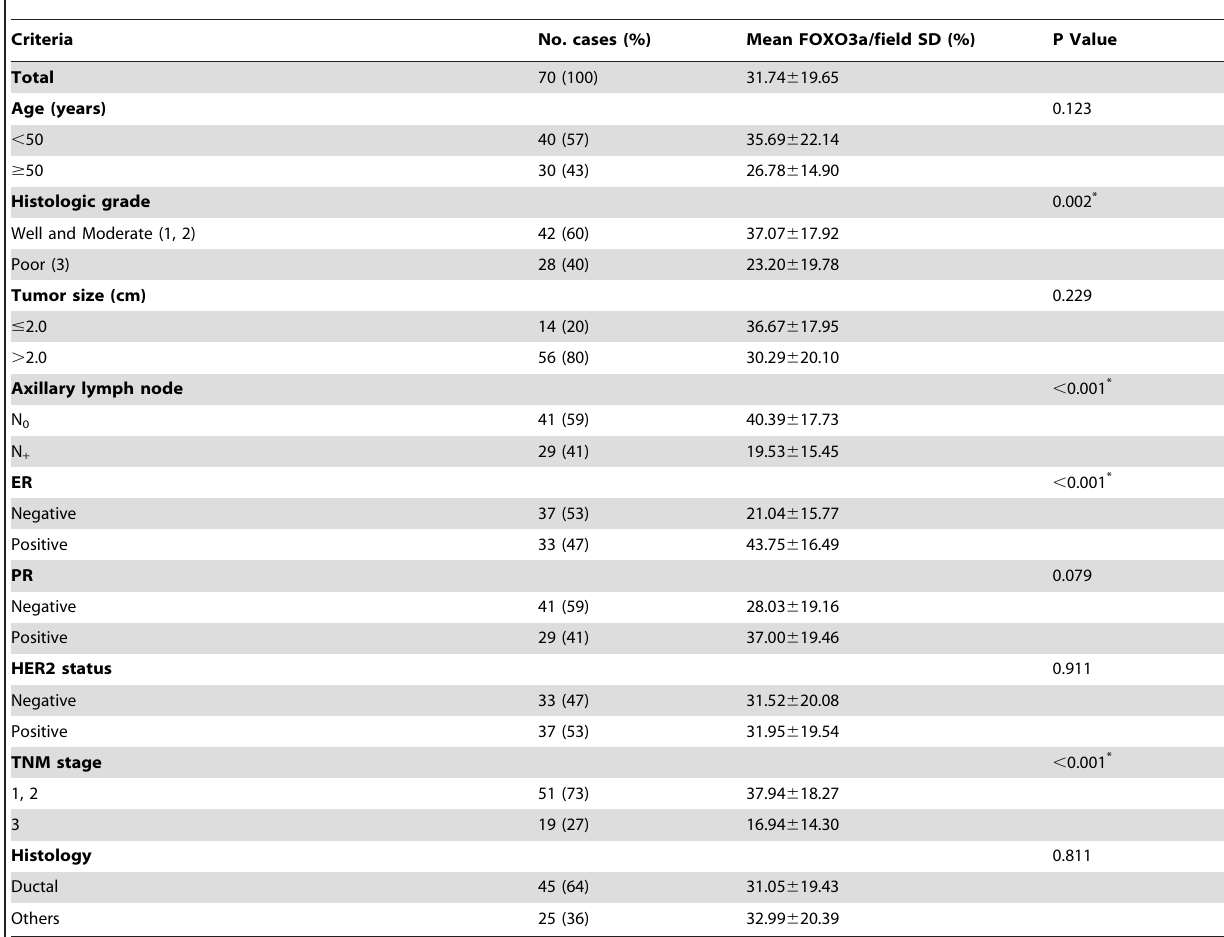
Table 1. Relationship between FOXO3a expression and clinicopathological features of the study population.